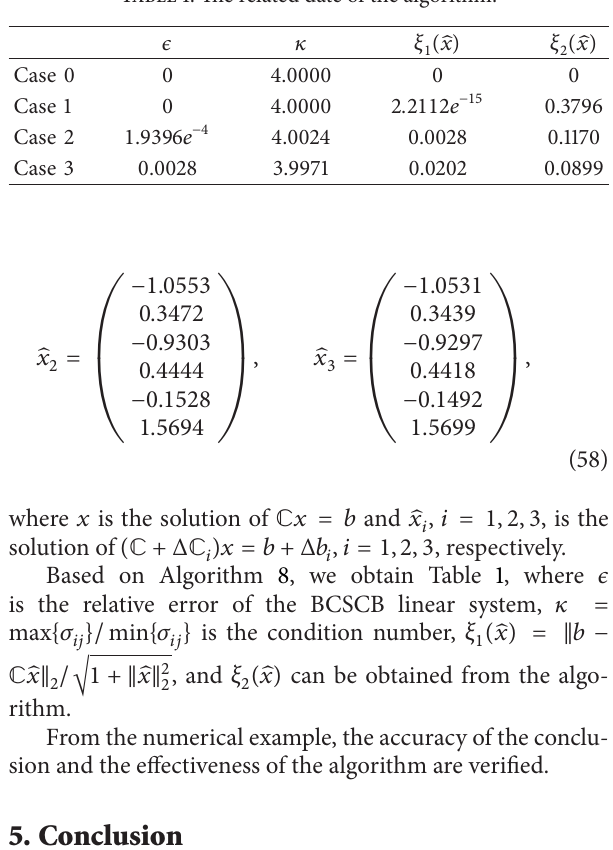
Table 1: The related date of the